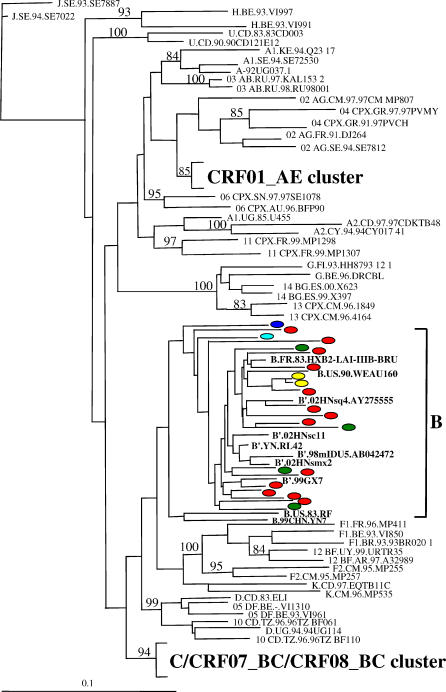
Phylogenetic Neighbor-Joining Tree for HIV-1 p17 Sequences Obtained from All 16 Prefectures of YunnanIndividual sequences are color coded, with the colors corresponding to those of original geographic sites on the map of Yunnan (Figure 1). The horizontal branch was drawn in accordance with their relative genetic distances. The vertical lines are present purely for clarity of the tree presentation. The bootstrap values of 1,000 replicates are labeled on the major branches. The reference sequences for classifying HIV-1 genotypes were included and were originally obtained from the NIH/NIAID–funded HIV Databases.